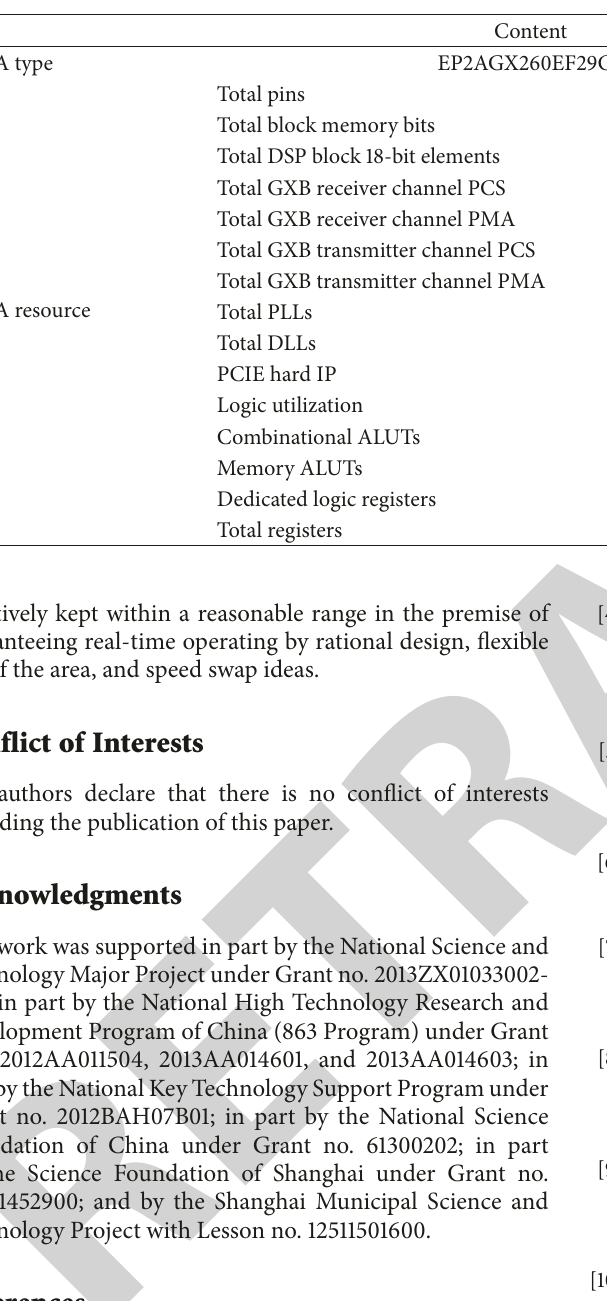
Table 1: The occupancy of FPGA